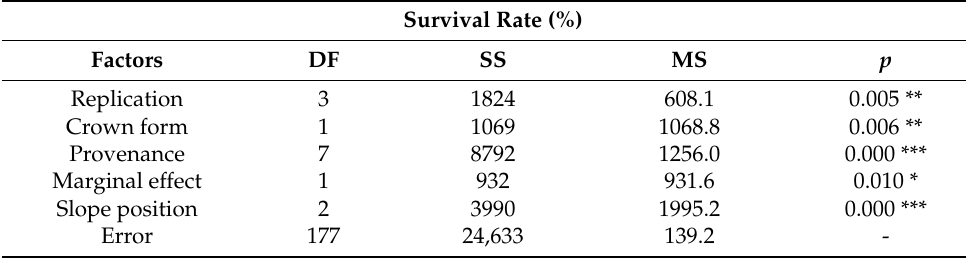
Figure 3. The variation of Sr in the four replications ( A ) and among provenances ( B ). The black vertical lines represent the standard deviation. Table 1. ANOVA for Sr in the M ă neciu trial.